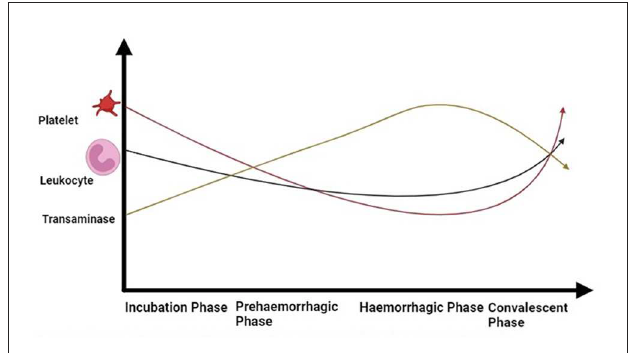
FIGURE5 Dynamic of blood cells during different phases of CCHF in patients (Drawn by BioRender app).